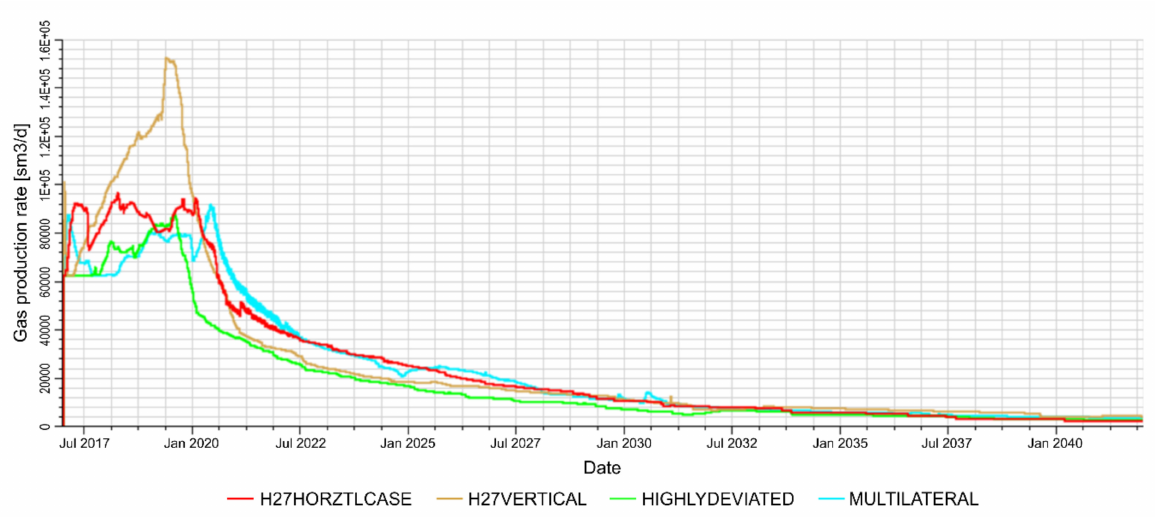
Figure 12. Field gas production rate for each well type.